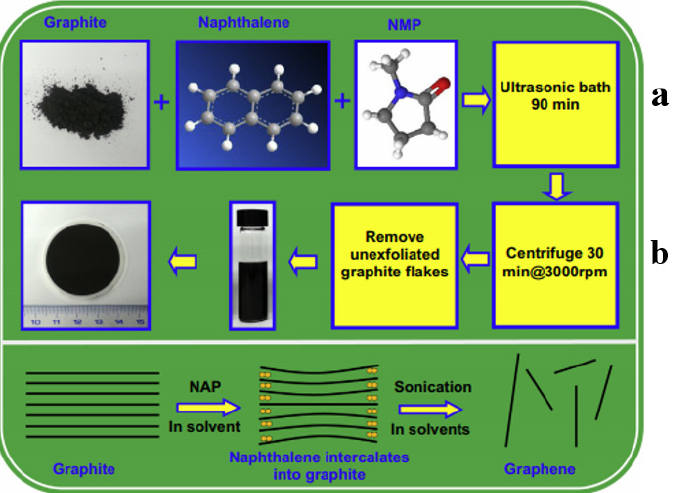
Figure 3. ( a ) Schematic of the exfoliation of graphene from graphite powder with the excess of naphthalene. The procedure includes different operations, including mixing, exfoliation, centrifugation, and vacuum filtration. ( b ) The illustration of the exfoliation of graphite using the π – π stacking interaction with naphthalene. Reprinted with permission from Ref. [72]. Copyright 2014, Elsevier.